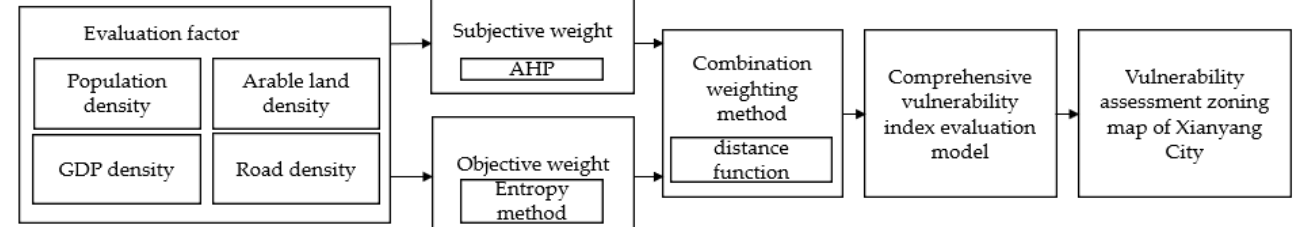
Figure 8. Flowchart of the disaster vulnerability assessment.